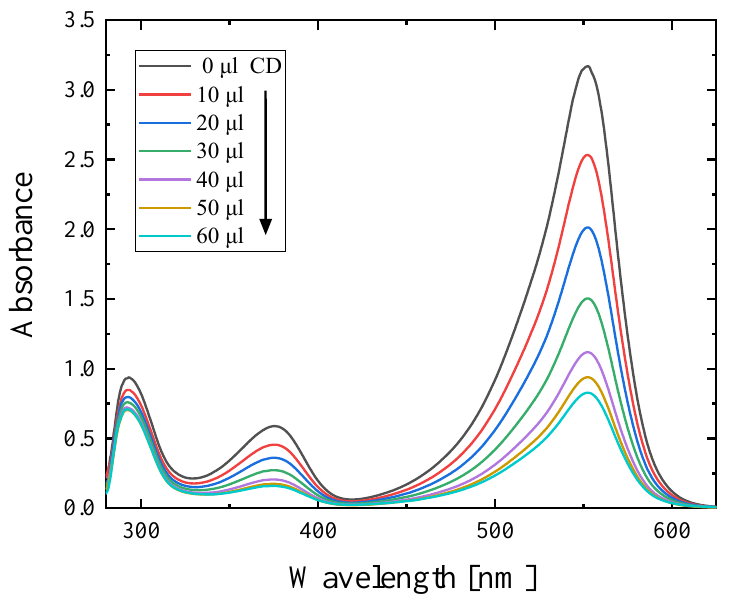
Figure 1. The UV–Vis absorption spectra of the phenolphthalein/ β -cyclodextrin solution. Figure 1. The UV – Vis absorption spectra of the phenolphthalein/ β -cyclodextrin solution. The absorption of PP after the addition of CD is given The structure of PP alters when encapsulated in β -cyclodextrin and the color of the solution transforms from pink to colorless. The absorption of pure PP is: